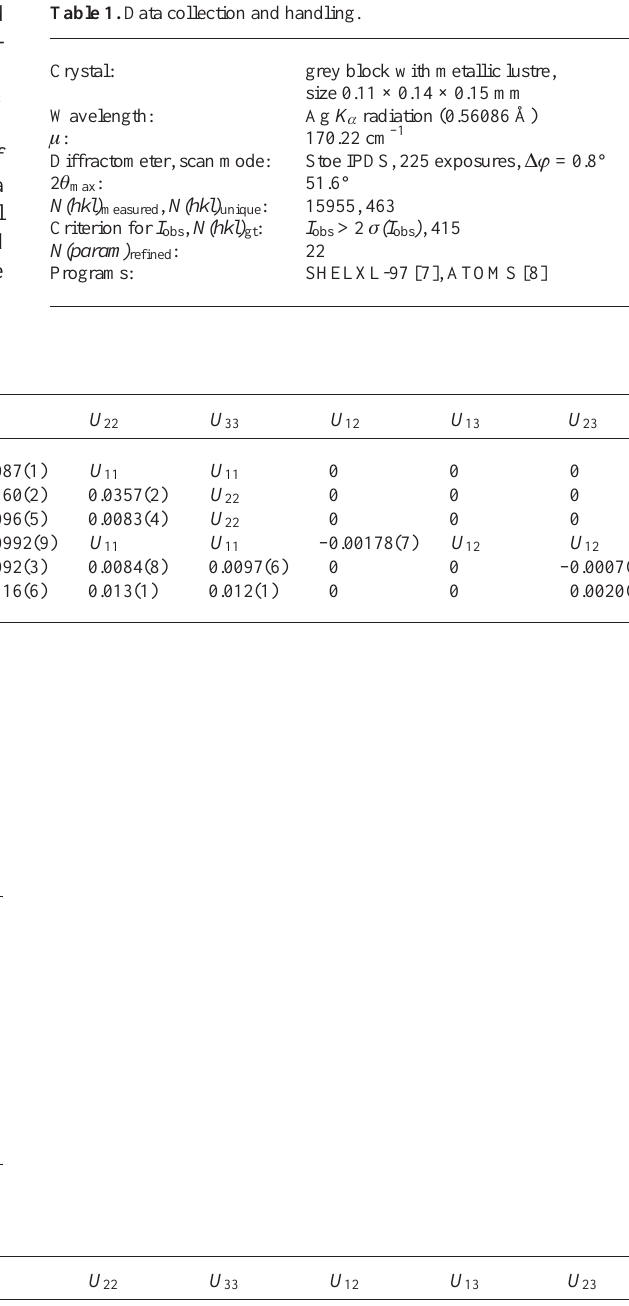
Table 1. Data collection and handling.